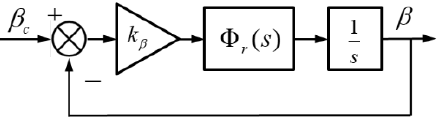
Figure 9. The structure of yaw angular rate loop